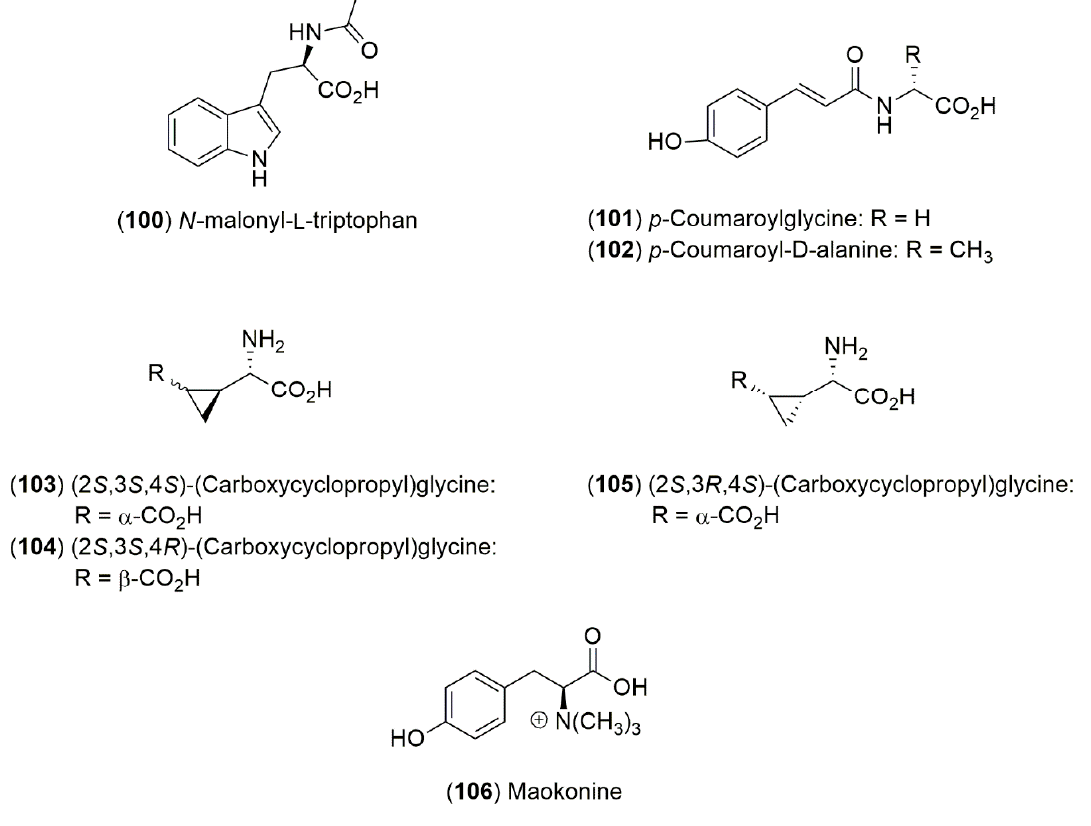
Figure 3. Structures of amino acid derivatives from Ephedra species.